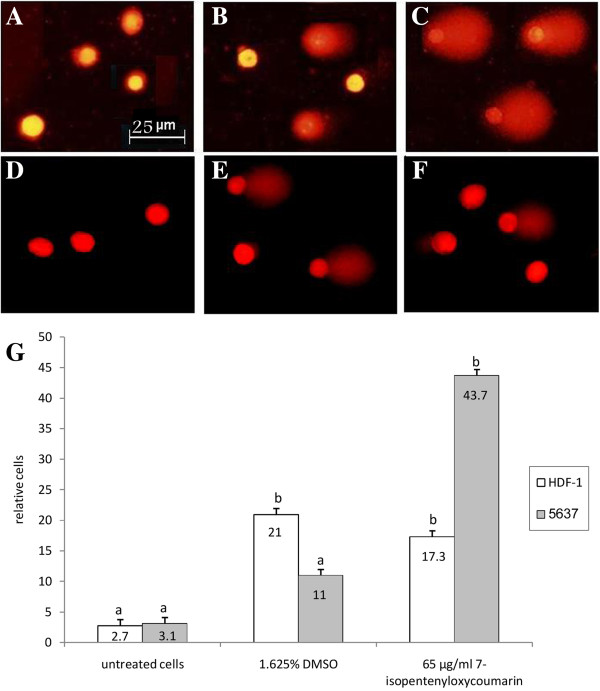
Evaluating the DNA damaging effects of 7-IP by comet assay. DNA damage of 5637 and HDF-1 cells without any treatment (A and D), treated with 1.625% DMSO (B and E) and treated with 65 μg/ml 7-IP (C and F) for 72 h, respectively. The percentages of damaged DNA, 72 h after treatments are compared with untreated and control groups in both 5637 and HDF-1 cells (G). Data are expressed as mean ± SD. The assay was repeated three times. Distinct letters show significant differences (P < 0.001) between different groups.